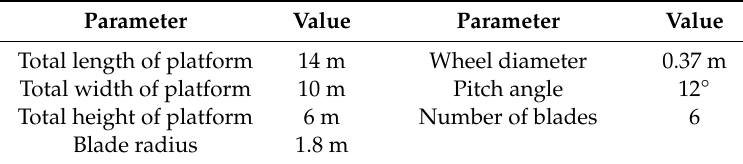
Figure 11. Periodic power and velocity diagram of tidal current.